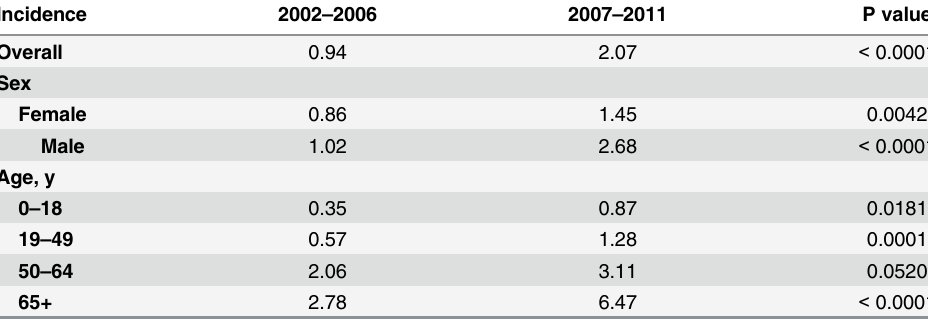
Table 2. Incidence rate (per one million person-years) by time period, stratified by age and sex.